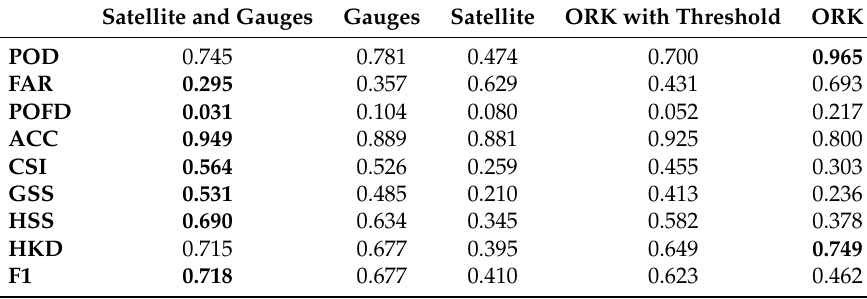
Table 7. Classification scores computed on the test set, for the model using both modalities ( Satellite and gauges ), the model using only the rain gauges ( Gauges ) the model using only the satellite channels ( Satellite ) and ordinary kriging using a precipitation detection threshold ( ORK with threshold ) and without applying any threshold ( ORK